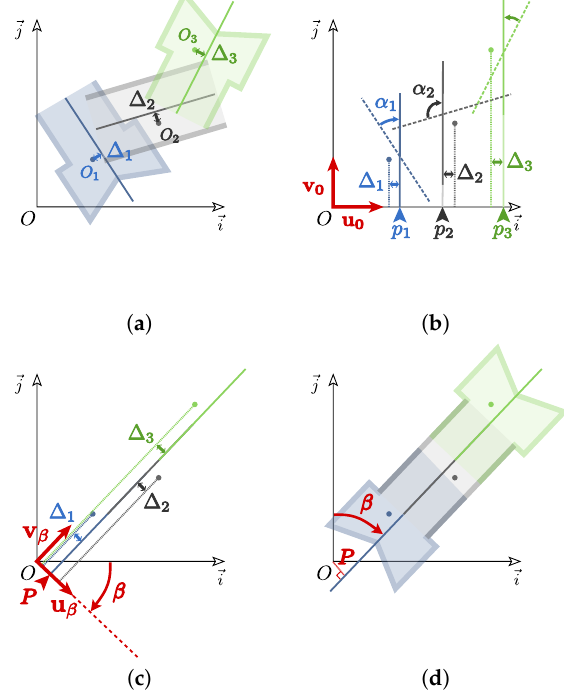
Figure 12. Illustration of the horizontal alignment procedure for sonar scans. ( a ) determination of the longitudinal axis for each digitization using PCA; ( b ) alignment of the axis of each digitization along the ordinate axis; ( c ) estimation of the second rotation to be applied to align the axes; ( d ) application of both rotations to each